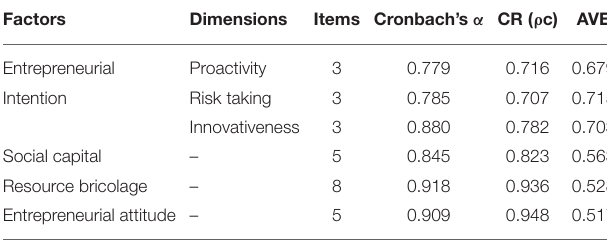
TABLE 4 | The Items and dimensions of the developed